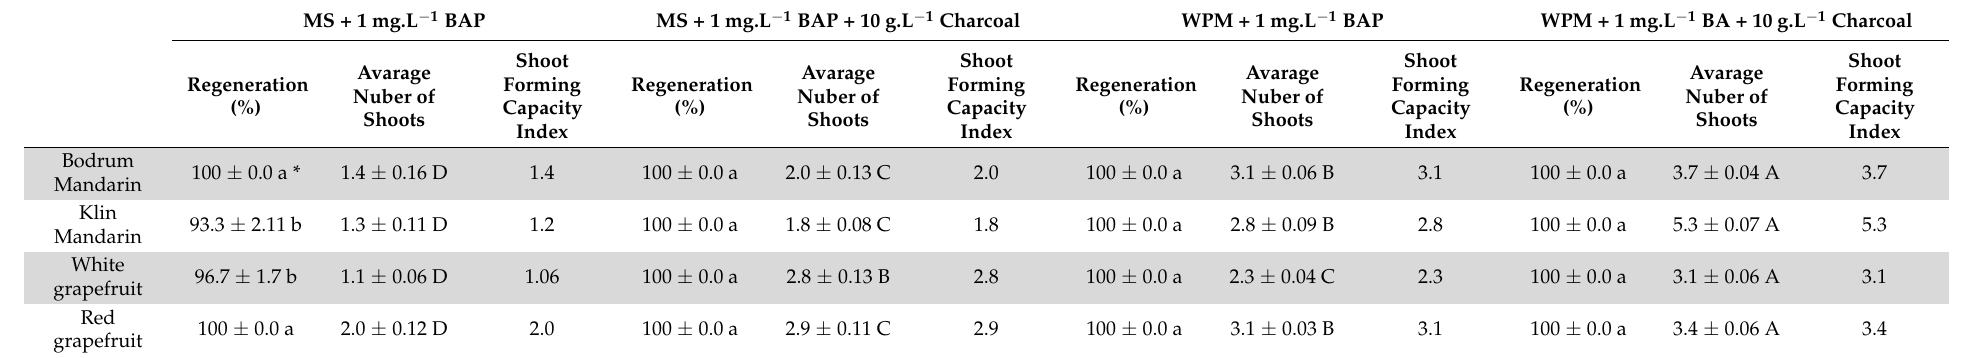
Table 1. The shoot tip regeneration, the number of shoots, and the shoot forming capacity (SFC) of four different Citrus spp. cultivars tested in different media combinations.